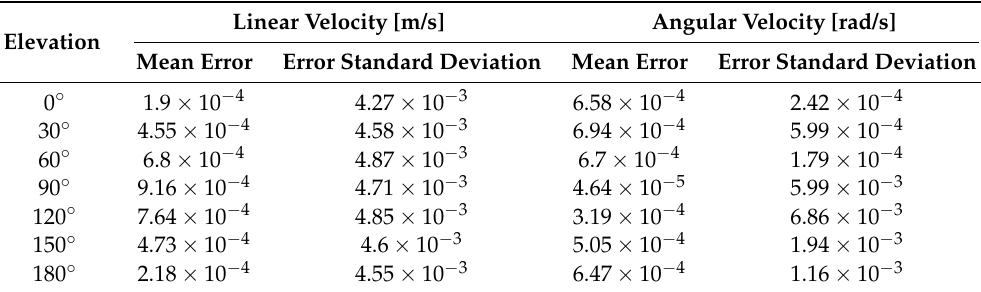
Table 4. Controller performance for robot navigation at different